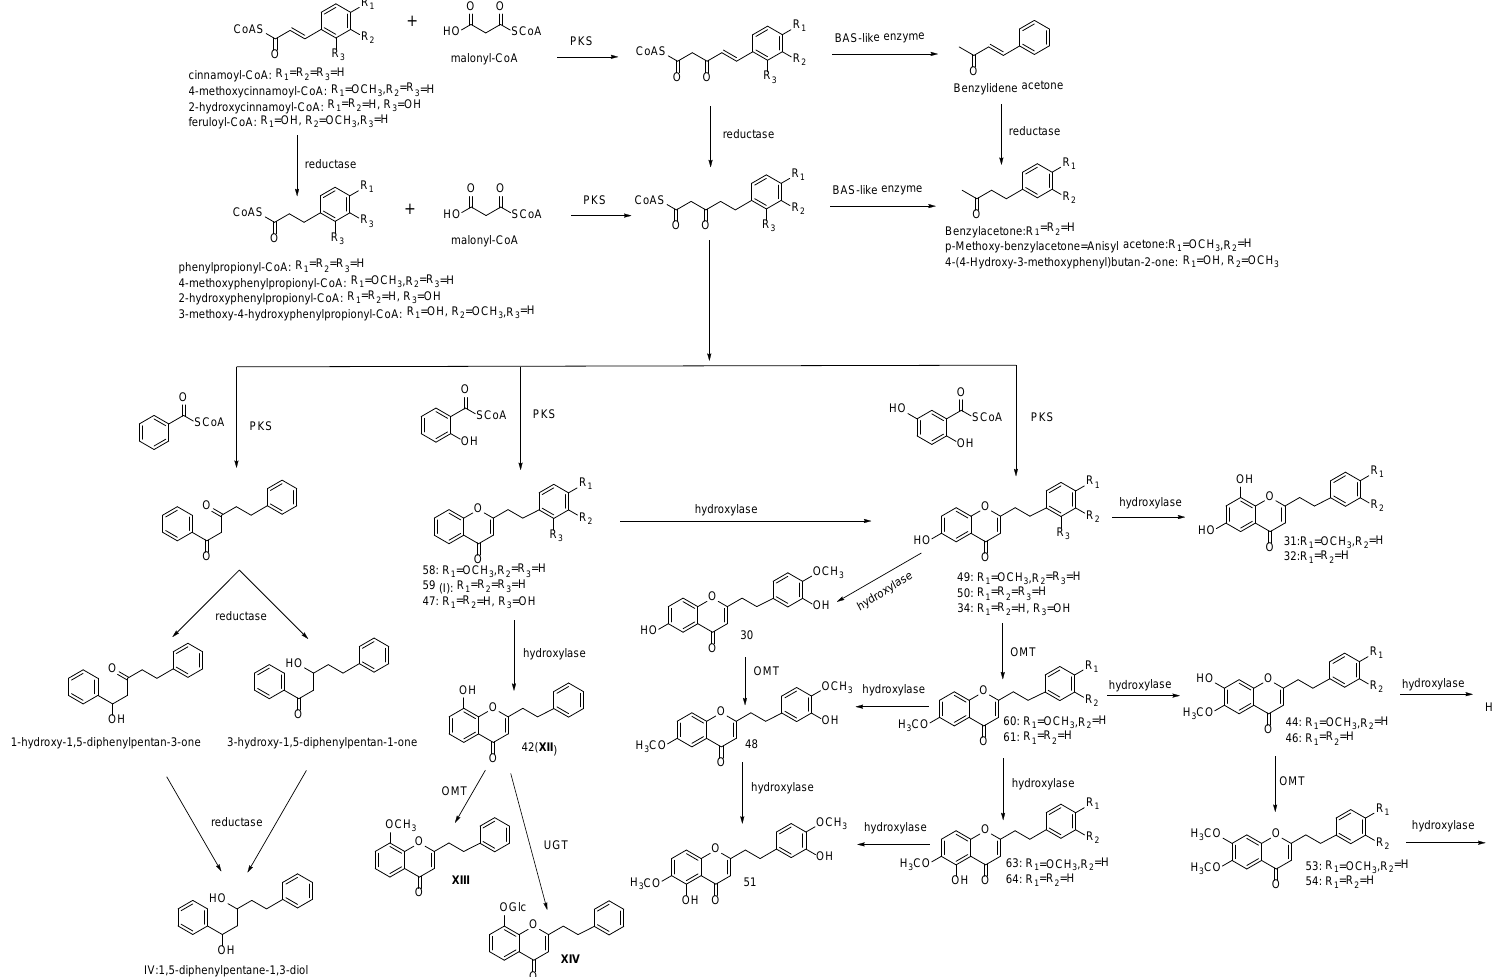
Figure 5. Hypothetical scheme for the biosynthetic pathway of PECs. OMT, O-methyltransferase, UGT, glycosyltransferase .